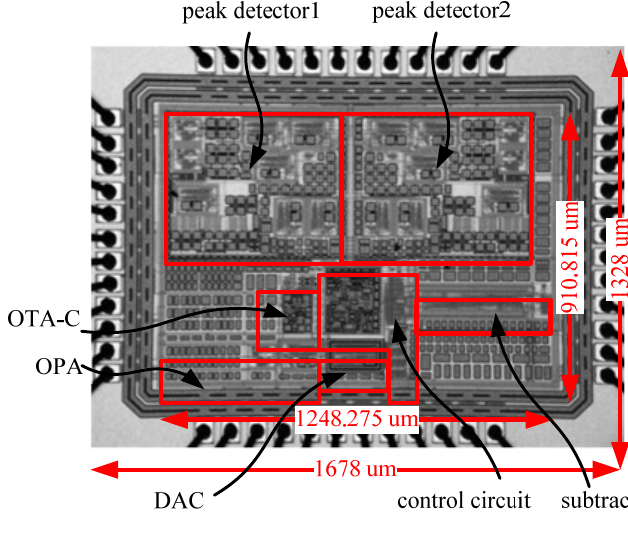
Figure 17. Die photo of the proposed frequency-shift readout